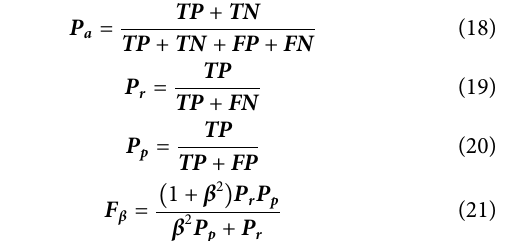
the fi re and non- fi re conditions are then evaluated.